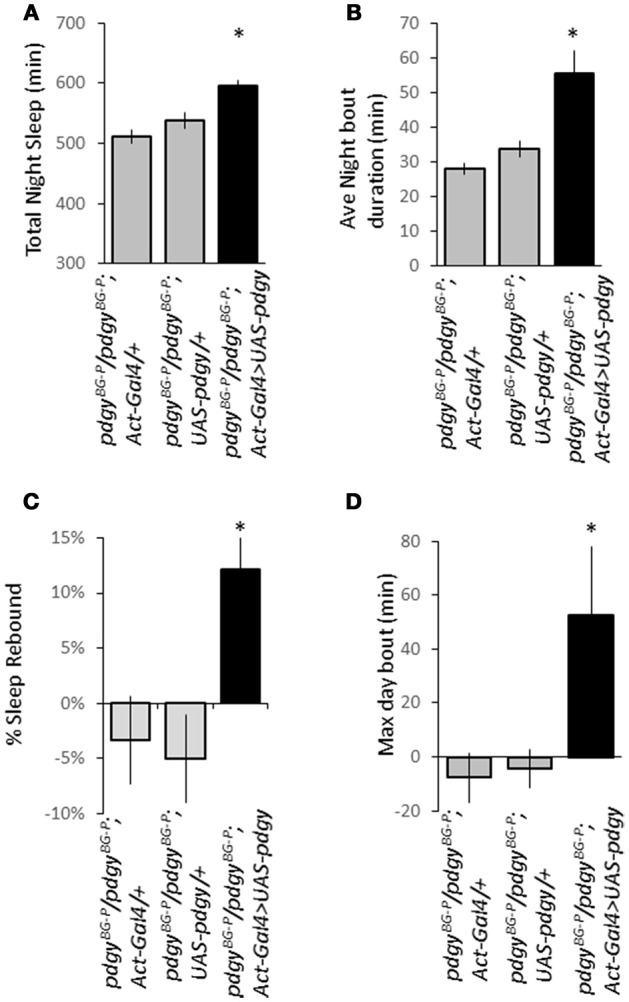
Rescue of pdgy in the pdgyBG−P background restores sleep homeostasis, duration, and consolidation. Re-introduction of the wild-type version of pdgy (dark bars) restores the duration of night time sleep (A) and increases the average night bout duration as a measure of sleep consolidation (B) compared to the driver (Act-GAL4/+) and the responder (UAS-pdgy) both in gray. (For both A,B, n = 63 for Act-GAL4/+, 64 for UAS-pdgy/+, and 61 for Act-GAL4>UAS-pdgy). (C) Rescue also restored a significant rebound after sleep deprivation. (D) The maximum day bout is increased on the first recovery day after sleep deprivation. For (C,D), n = 29 for Act-GAL4/+, 26 for UAS-pdgy/+, and 30 for Act-GAL4>UAS-pdgy. *p < 0.05.